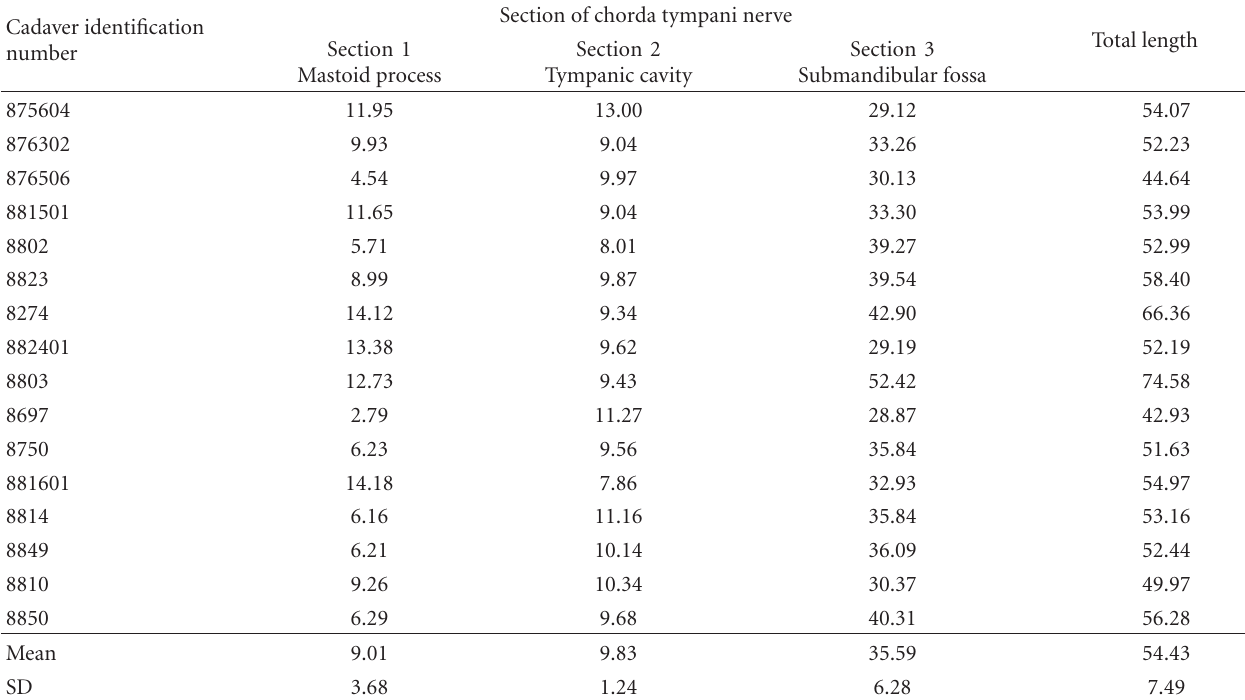
Table 1: Measurements of the chorda tympani nerve in